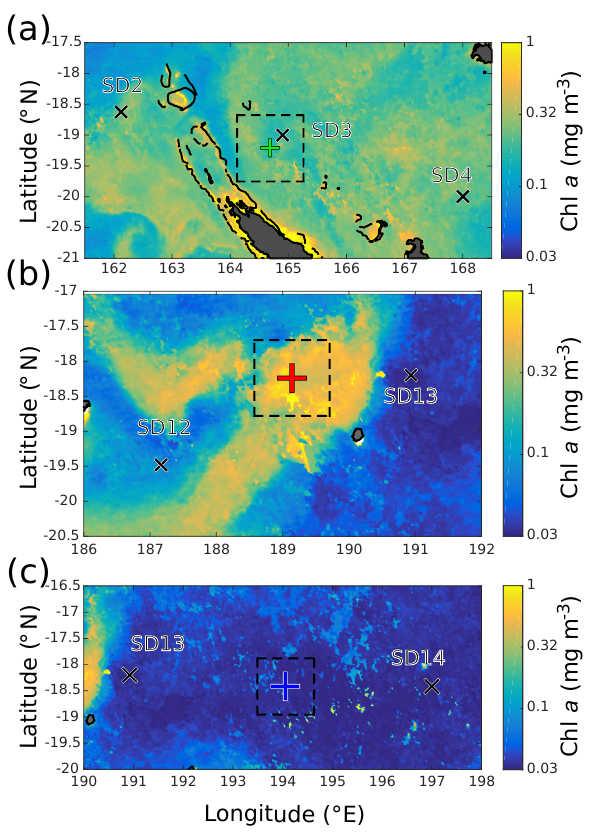
Figure 2. Satellite chl a around (a) LDA, (b) LDB, and (c) LDC. SD stations shown by black crosses, land is shaded gray, and coastlines and reefs are plotted in black. LD stations shown by plus symbols following the color code from Fig. 1. Squares with 120km to a side plotted around each LD station to represent approximate Rossby radius R D